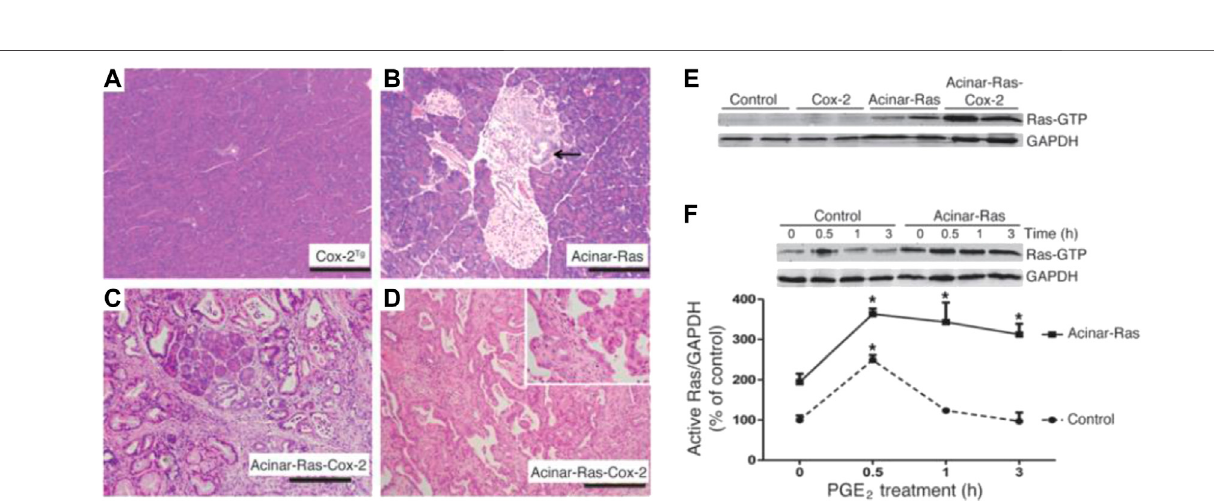
Frontiers in Pharmacology |